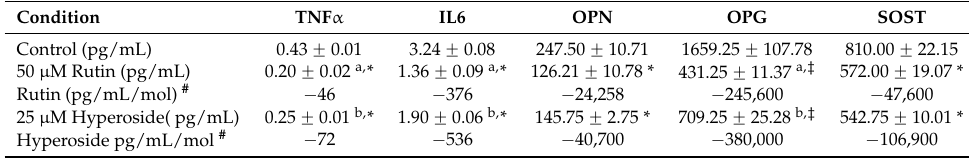
Table 1. Concentration of regulatory proteins involved in osteoblast